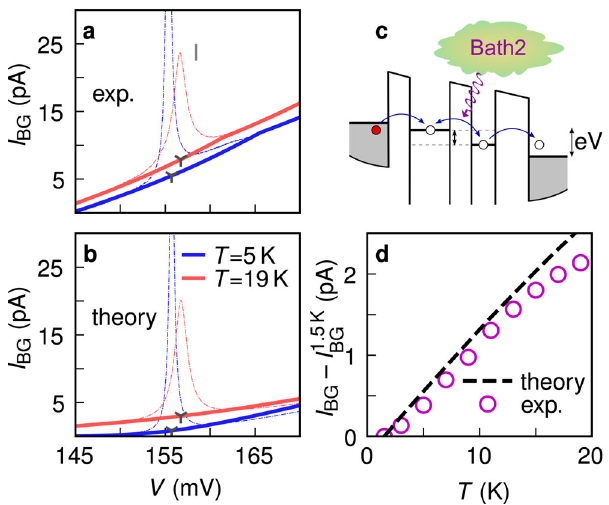
Fig. 3 Analysis of the background. a Measured tunneling current for the fi rst peak for two different temperatures (thin dot-dashed lines) and subtracted background (thick solid lines). b Corresponding theoretical results. c Sketch of the coupling of the tunnel operator to bath 2 which causes a smooth background current. d Shift of the current baseline from its value at 1.5 K in dependence of the temperature, I BG (cid:2) I 1 : 5K position of the latter. The theoretical values are computed with α 0 ¼ 2 : 2 (cid:4) 10 (cid:2) 6 , while all other parameters are as in Fig.